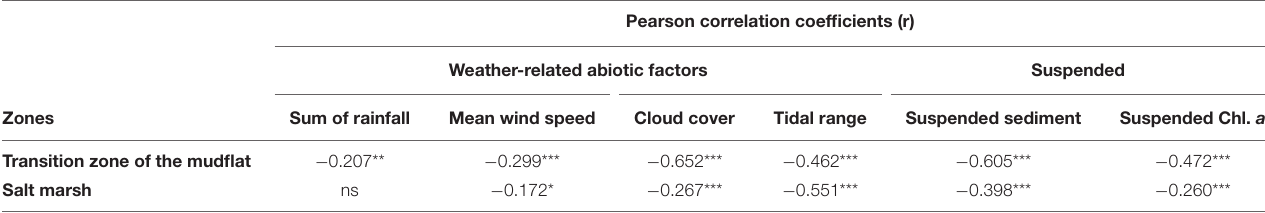
TABLE 2 | Correlations between Chl. a concentration with weather-related abiotic factors and suspended water properties during August and September 2015 on two different intertidal zones at Fingringhoe Wick, Colne Estuary, Essex, United